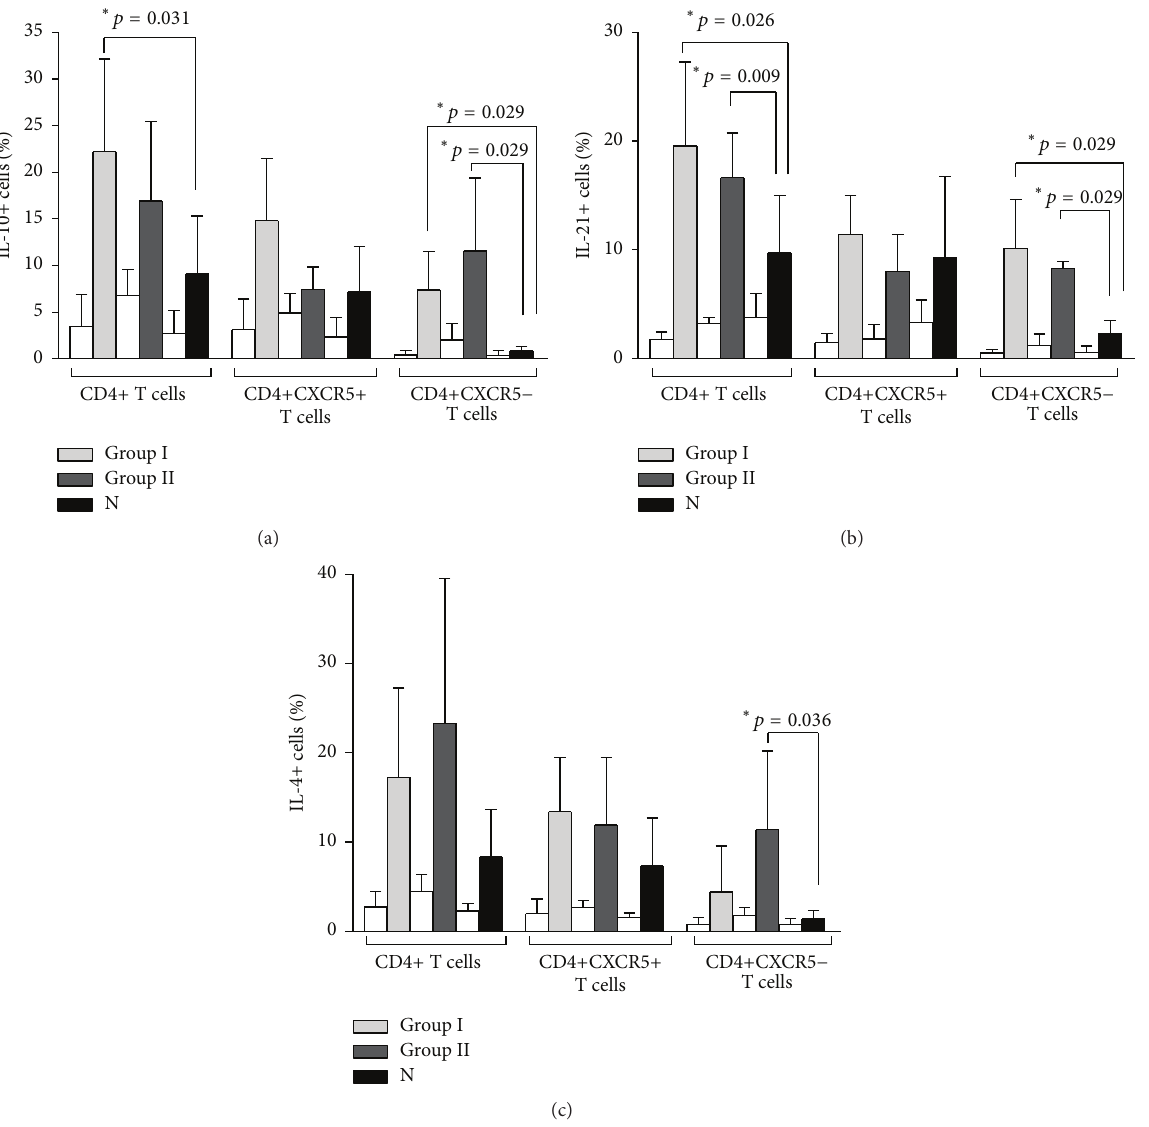
Figure 4: Intracellular cytokines after PHA+IL-2 stimulation of PBMC in CVID and N. The percentage of intracellular cytokines ((a) IL-10, (b) IL-21, and (c) IL-4) in permeabilized CD4+ T cells (CXCR5+ and CXCR5 − ) was determined after 7 days of PHA+IL-2 stimulation in CVID Group I ( 𝑛 = 4 ), Group II ( 𝑛 = 4 ), and N ( 𝑛 = 6 ). Statistical differences are consigned in the graph. White bars represent unstimulated